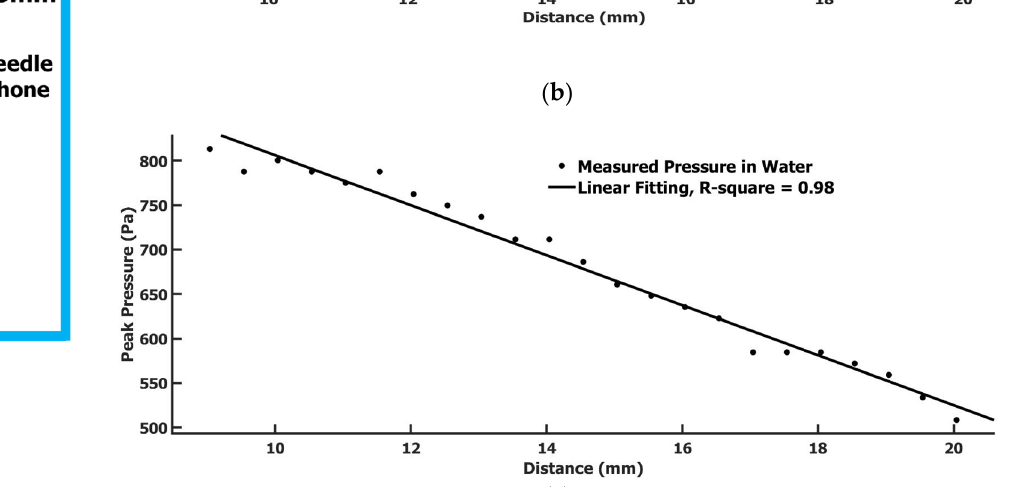
Pressure air = − 8.06 ∗ x distance +